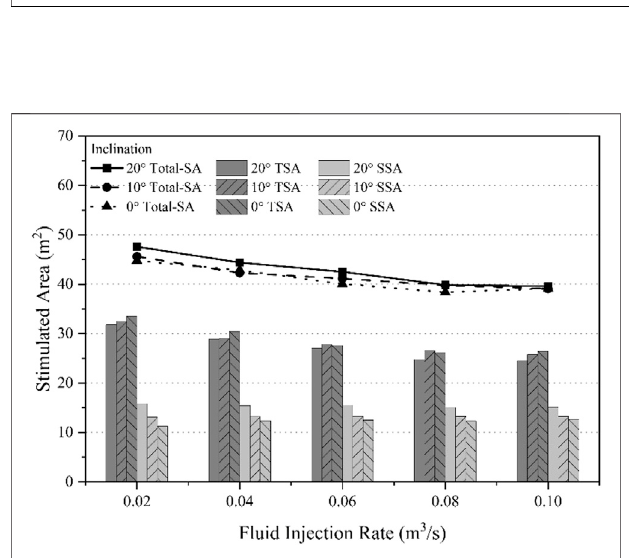
FIGURE 11 | Effect of the fl uid injection rate and inclination on tension and shear stimulated areas (TSA and SSA).